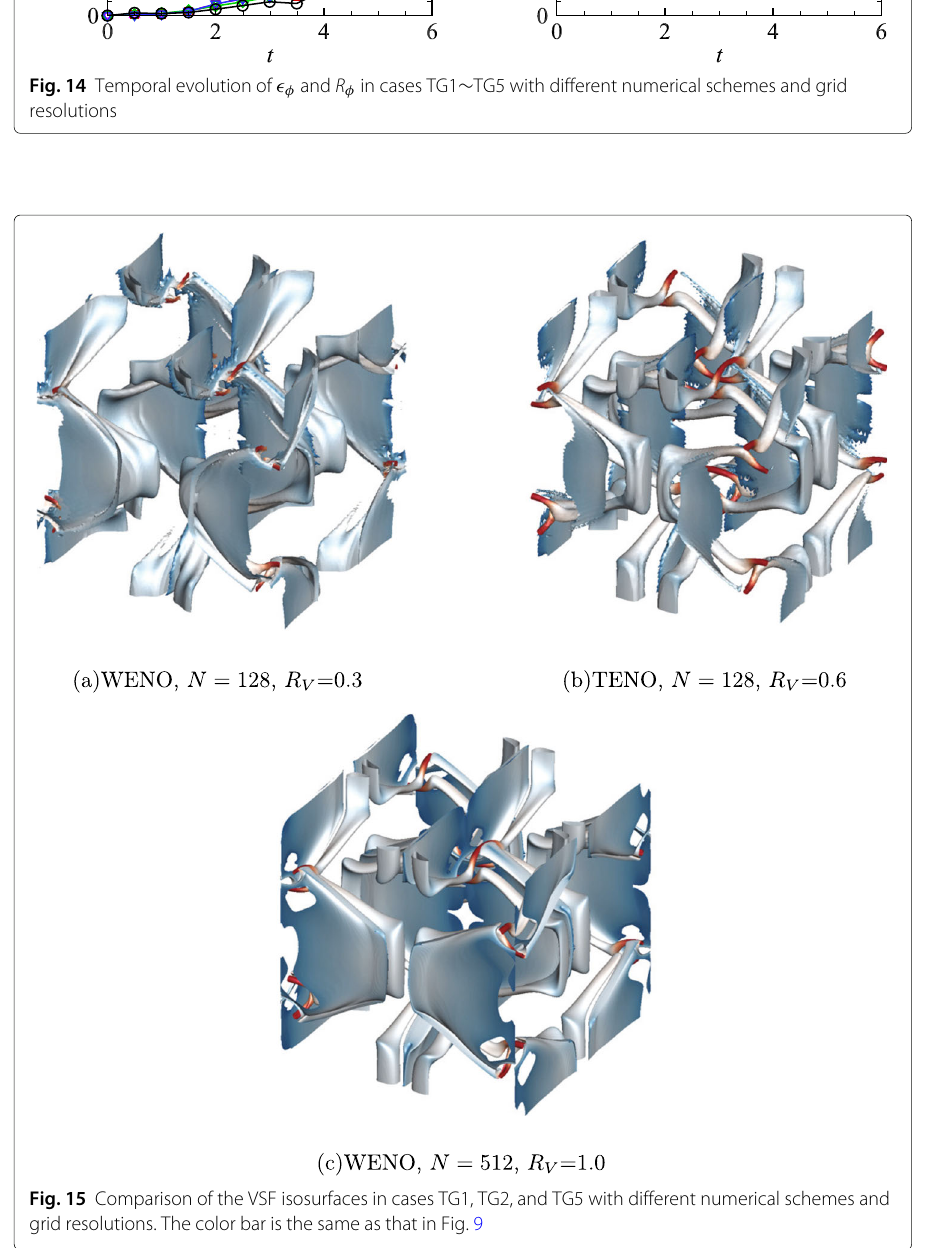
Fig. 15 Comparison of the VSF isosurfaces in cases TG1, TG2, and TG5 with different numerical schemes and grid resolutions. The color bar is the same as that in Fig.